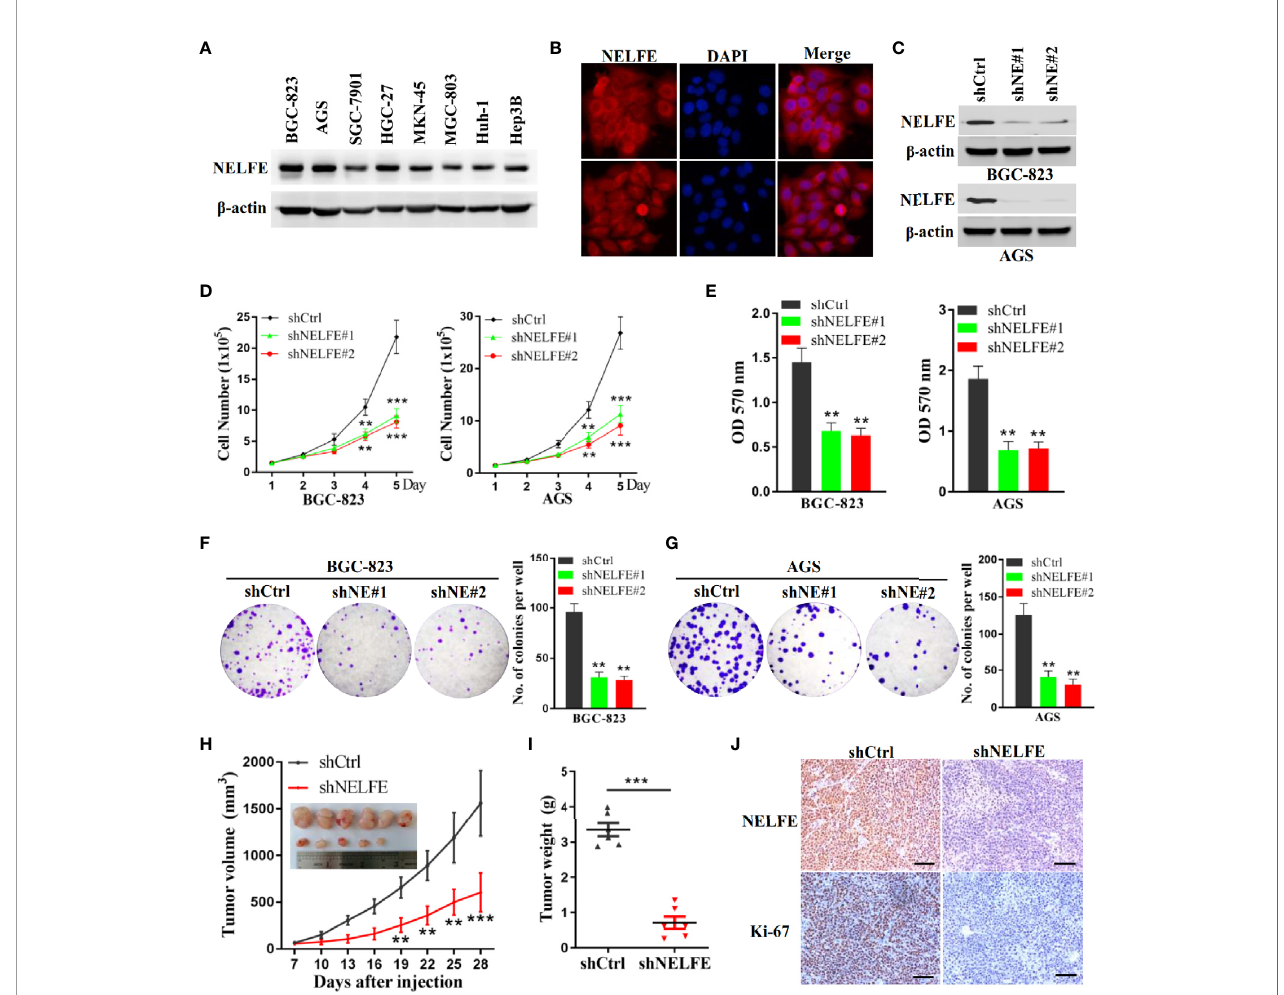
FIGURE 2 | NELFE promoted the proliferation of human gastric cancer cells. (A) The expression levels of NELFE were examined by western blotting in liver cancer cells (Huh-1 and Hep3B) and gastric cancer cells (BGC-823, AGS, SGC-7901, HGC-27, MKN-45, and MGC-803). (B) The distribution of the NELFE protein in the cells was examined by immuno fl uorescence experiments. BGC-823 and AGS gastric cancer cells were transfected with sh-NELFE#1, sh-NELFE#2, or sh-control. (C) The protein expression level of NELFE was detected by western blotting. Actin was used as control. (D, E) Cell viability was measured by the MTT assay. (F, G) A cell colony formation assay was performed in BGC-823 and AGS cells. (H, I) Five-week-old male nude mice were used in xenograft assays, and BGC-823 cells were mixed with Matrigel and injected subcutaneously into the fl anks. (J) The proportion of ki67-expressing cells in xenograft tumors was examined by immunohistochemical examination. **P < 0.01, ***P <